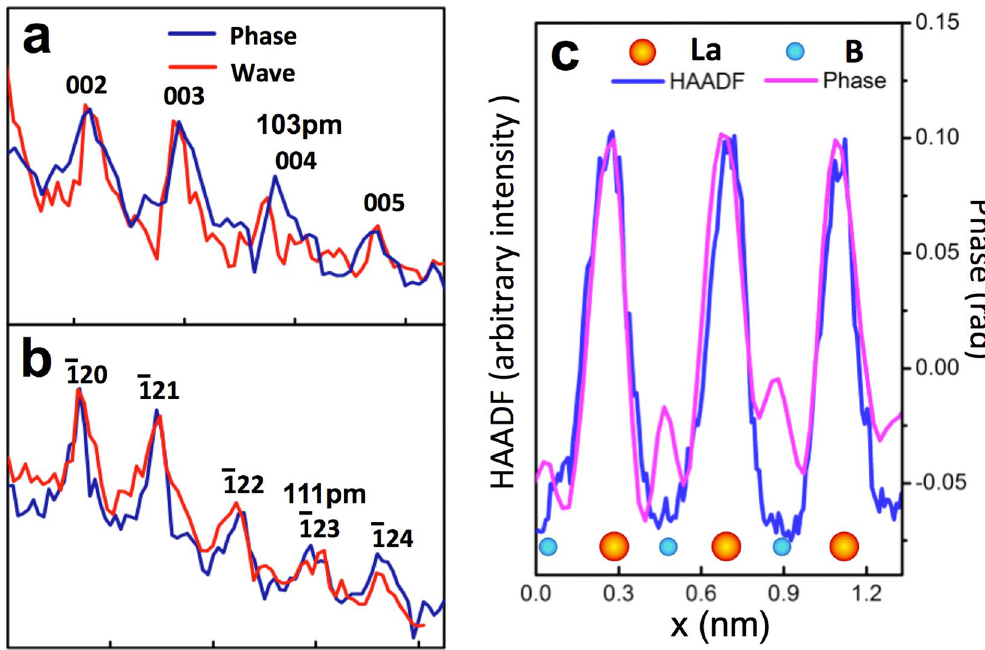
Figure 3. Reciprocal space intensity profiles with a width of 3 pixels extracted from power spectra along the lines L1 ( a ) and L2 ( b ) marked in Fig. 2(c) ( phase ) and Fig. 2(d) ( complex wave ), respectively. ( c ) Line profiles with a width of 3 pixels extracted from the reconstructed phase and the HAADF image along the lines marked with green arrows in Fig. 2(a) and (b),